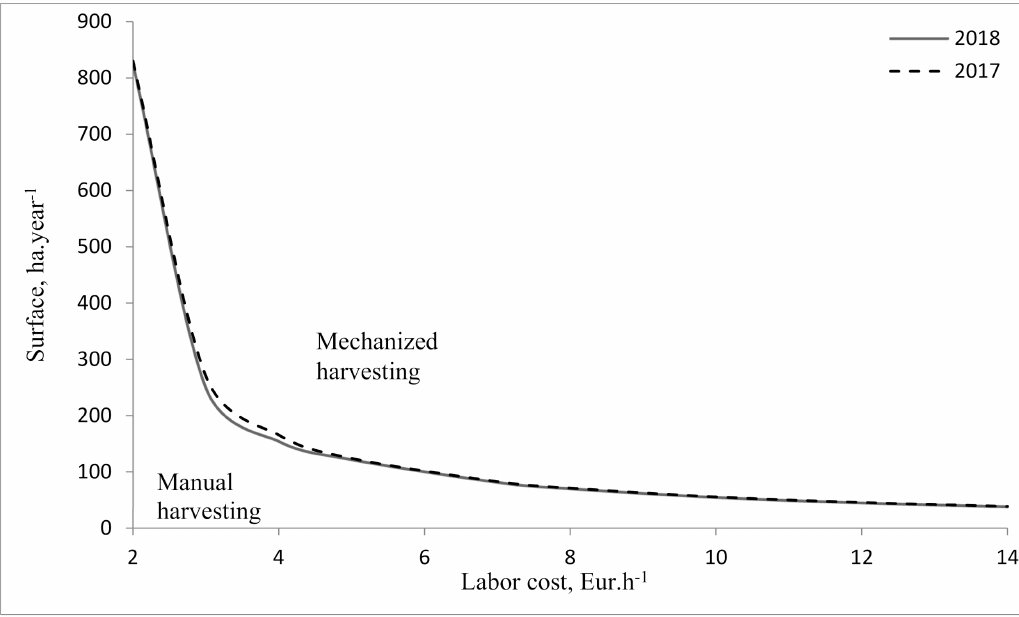
Figure 6. Break-even areas under different combinations of harvested area and labor